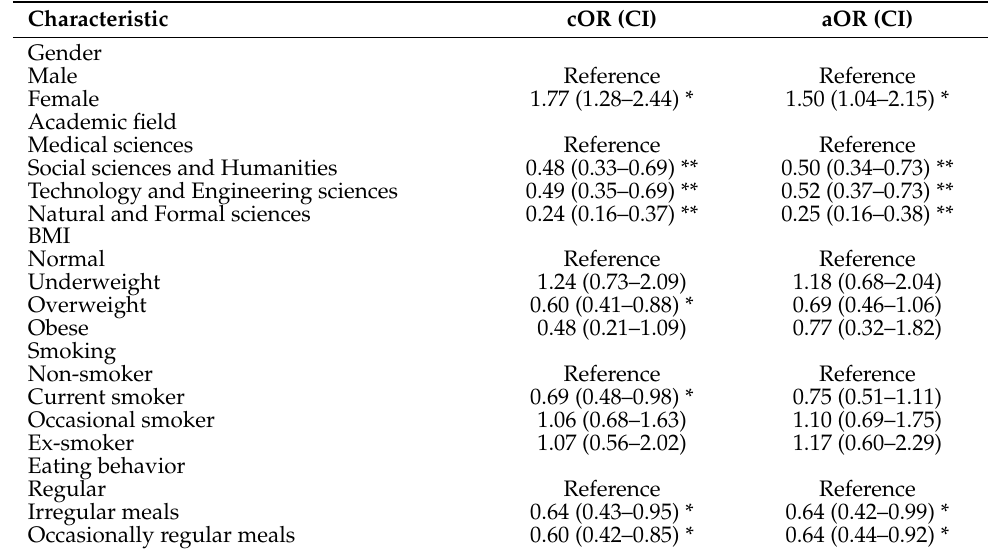
Table 3. Logistic regression analysis of independent predictors of dietary supplement